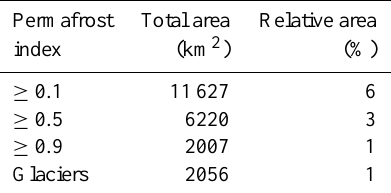
Table 5. Estimated permafrost index areas for the entire Alps. The relative area refers to the total area of the Alps (ca. 200000km 2